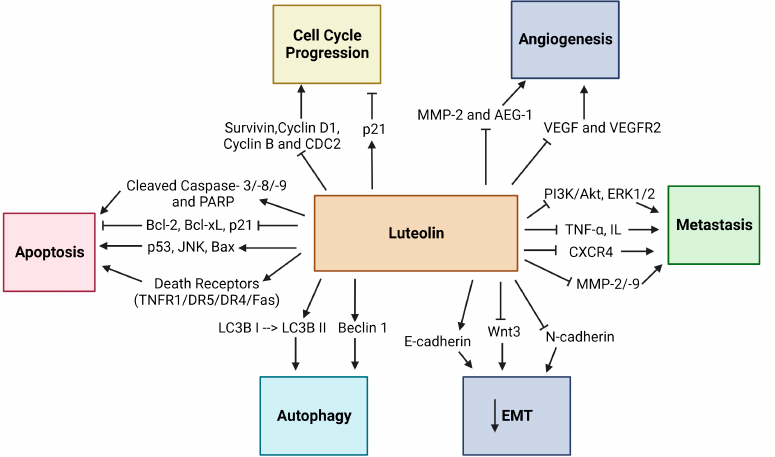
Figure 2. Summary of Luteolin’s regulation of apoptosis, metastasis, angiogenesis, autophagy, cell cycle progression, and EMT in cancer cells. Luteolin was discovered to promote apoptosis of different cancer cells by increasing Death receptors, p53, JNK, Bax, Cleaved Caspase-3/-8-/-9, and PARP expressions and downregulating antiapoptotic proteins such as Bcl-2 and Bcl-xL. It can also inhibit the progression of the cell cycle by downregulating proteins involved in cell cycle progression, including Survivin, Cyclin D1, Cyclin B, and CDC2, and upregulating p21 expression. Luteolin was found to suppress angiogenesis in cancer cells by inhibiting the expression of some angiogenic factors, such as MMP-2, AEG-1, VEGF, and VEGFR2, and inhibit metastasis by inhibiting several proteins that function in metastasis, such as MMP-2/-9, CXCR4, PI3K/Akt, ERK1/2. It can promote the conversion of LC3B I to LC3B II and upregulate Beclin1 expression, thereby causing autophagy induction in cancer cells. Additionally, Luteolin was identified to suppress the epithelial to mesenchymal transition by upregulating E-cadherin and downregulating N-cadherin and Wnt3